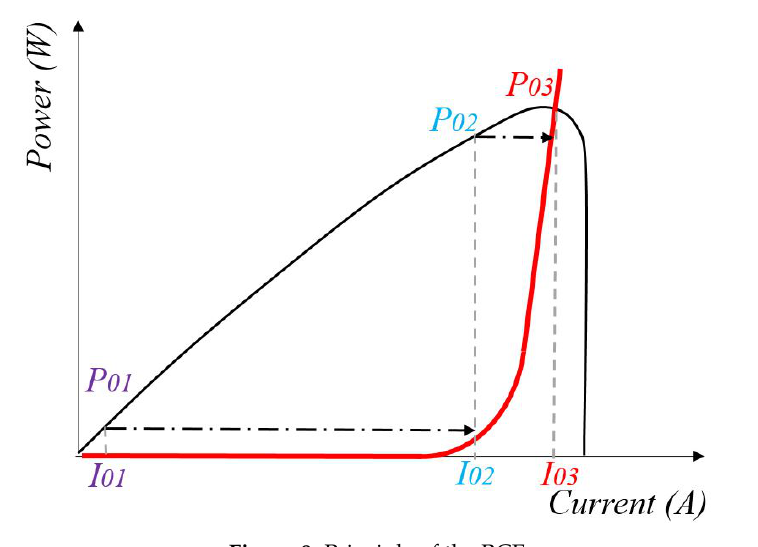
Figure 8. Principle of the